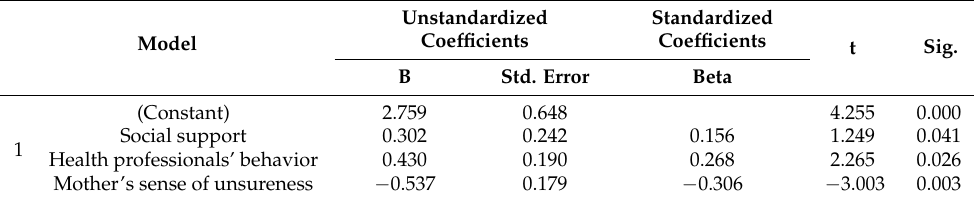
Unstandardized Coefficients